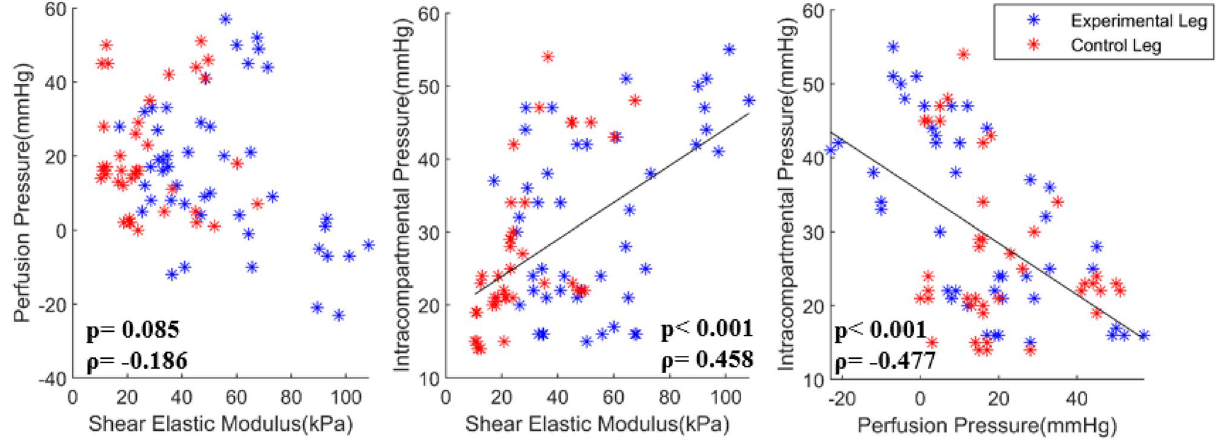
Figure 6. Shear elastic modulus versus intracompartmental pressure, shear elastic modulus versus perfusion pressure, and intracompartmental pressure versus perfusion pressure in the shear wave elastography group. Each blue asterisk indicates each data point from all time points of the experimental leg, and each red asterisk indicates each data point from all time points of the control leg in the shear wave elastography group.